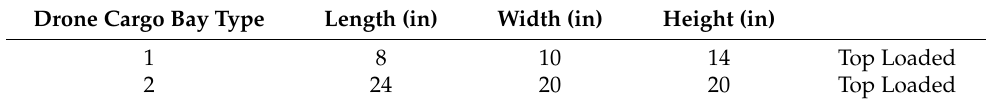
Table 5. Drone Cargo Bay Packing Configuration/Dimensions by